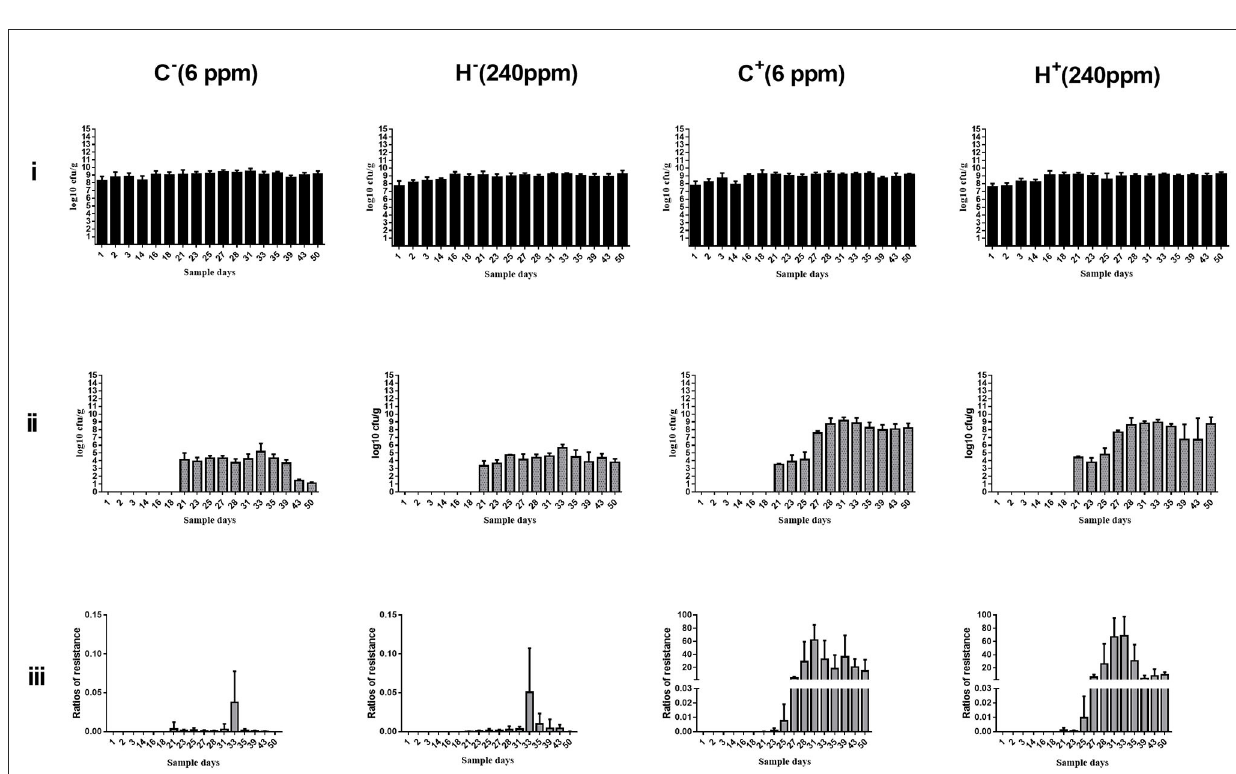
FIGURE3 Changes in culturable/cefotaxime-resistant E. coli numbers in the individual fecal samples in different groups. (i) Change in culturable E. coli numbers of the fecal samples in different groups. (ii) Change in cefotaxime-resistant E. coli numbers of the fecal samples in different groups. (iii) Change in ratios of cefotaxime-resistant isolates of the fecal samples in different groups. E. coli TC4-2 was inoculated on D20, D22, D24, D26, D27, and D28 in all groups.